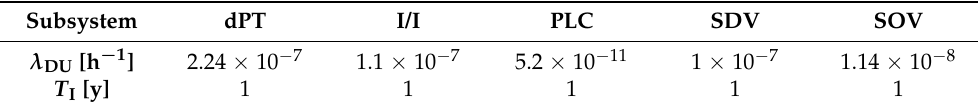
Table 8. Reliability data.